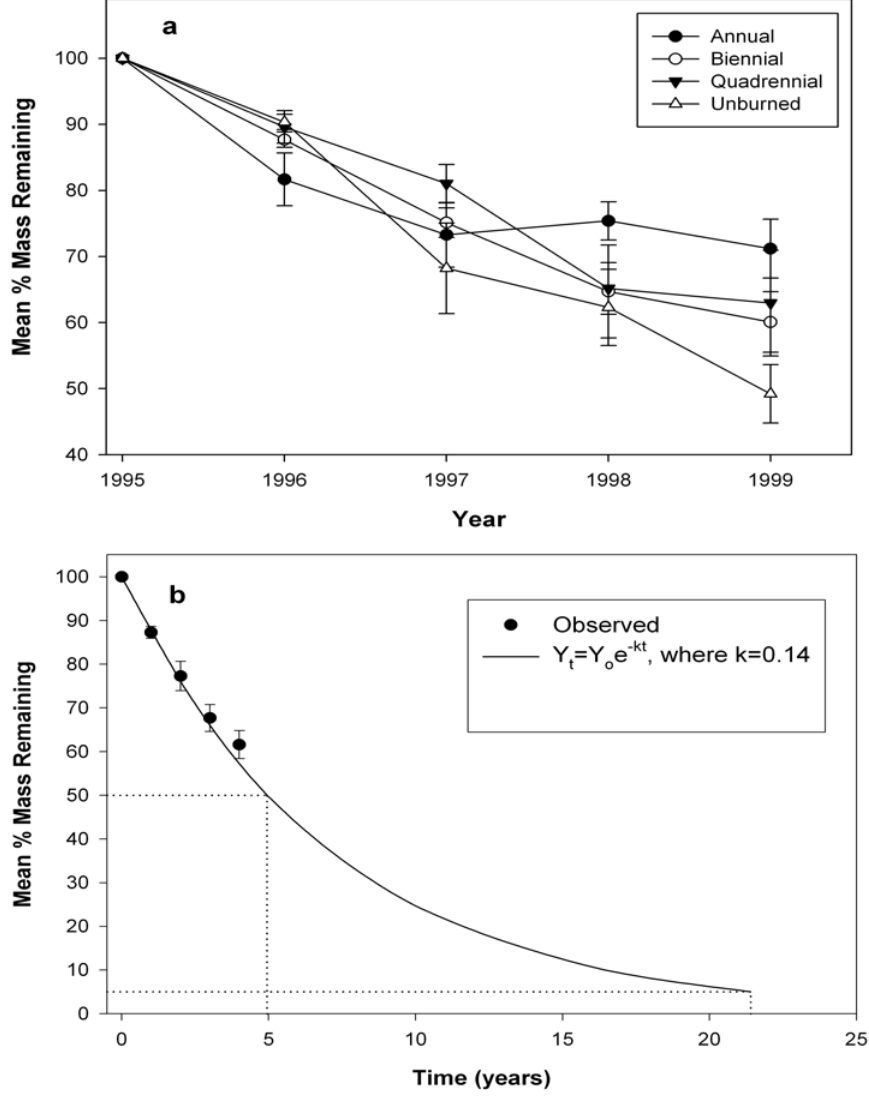
Figure 1. ( a ) Mean (±SE) percent of mass remaining in longleaf pine logs placed on plots receiving dormant season prescribed burns at different frequencies over 40 years on the Osceola National Forest, Baker County, Florida; ( b ) Observed mean (±SE) percent mass remaining for all logs sampled in a given year and the projected mass loss from logs assuming decay follows the single-exponential model and the decay coefficient estimated from the first four years of decomposition remains